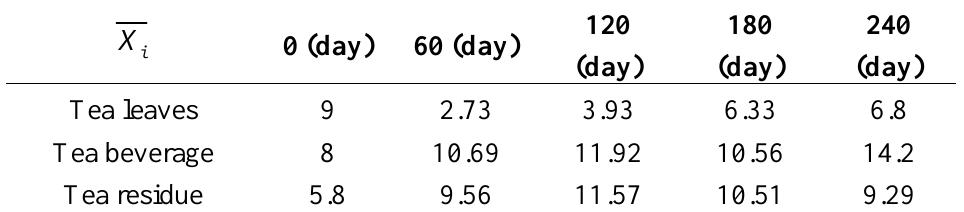
Table 2. The errors of the testing